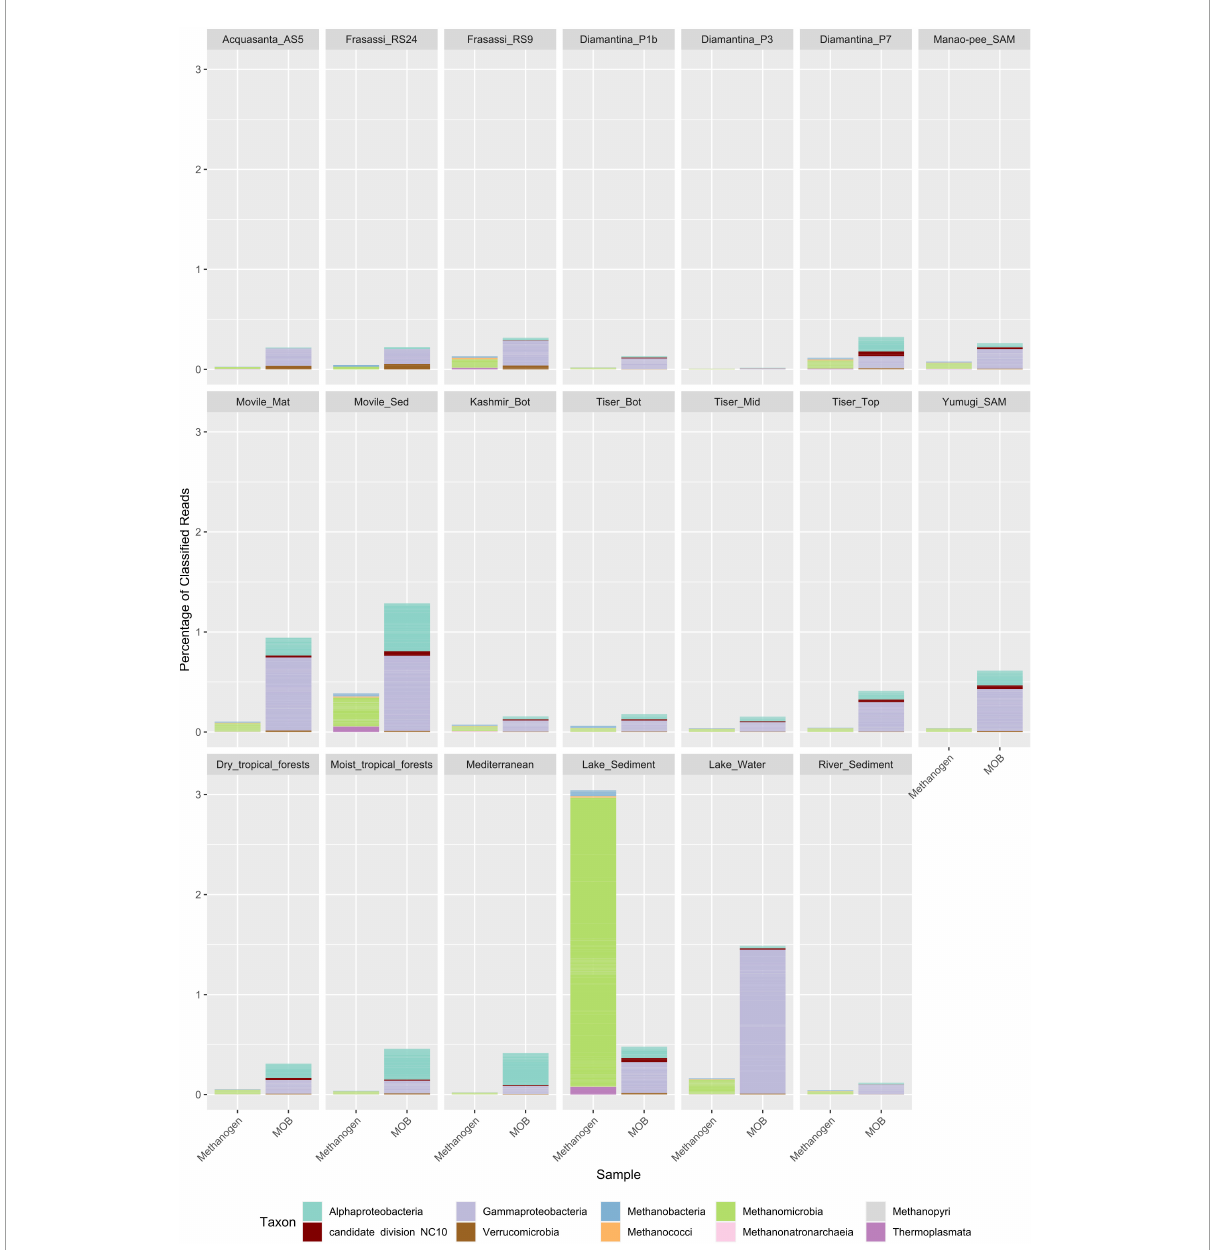
FIGURE1 Taxonomic composition of methane-oxidizing bacteria (MOB) and methanogen classified reads at class. Sequencing read classification was carried out using Kaiju against the NCBI non-redundant (nr) protein database. MOB and methanogen taxa were retrieved from Kaiju output at the genus level based on a database of known MOB and methanogen genera using the NCBI taxa names. Values shown are percentage of classified sequences for the respective metagenome ( Supplementary Table 2